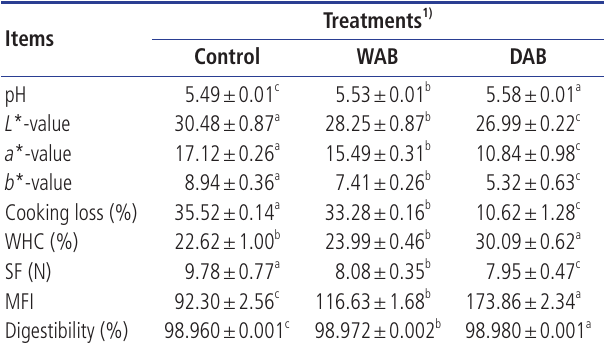
Table 1. Effect aging methods on pH, color, cooking loss, water holding capacity, shear force, myofibrillar fragmentation index, and digestibility (%) of beef loins Items